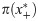
A mixing distribution π(x+*) for SVE with oversampling.The distribution of transition kernels, i.e., π(x+*), for sampling from the posterior π(θ ∣ x+ = 9) when choosing the best one out of m = 5 generated proposals (left panel) and m = 20 generated proposals (right panel). In this example the acceptance rate was equal to 75% when generating m = 5 proposals and equal to 95% when generating m = 20 proposals.